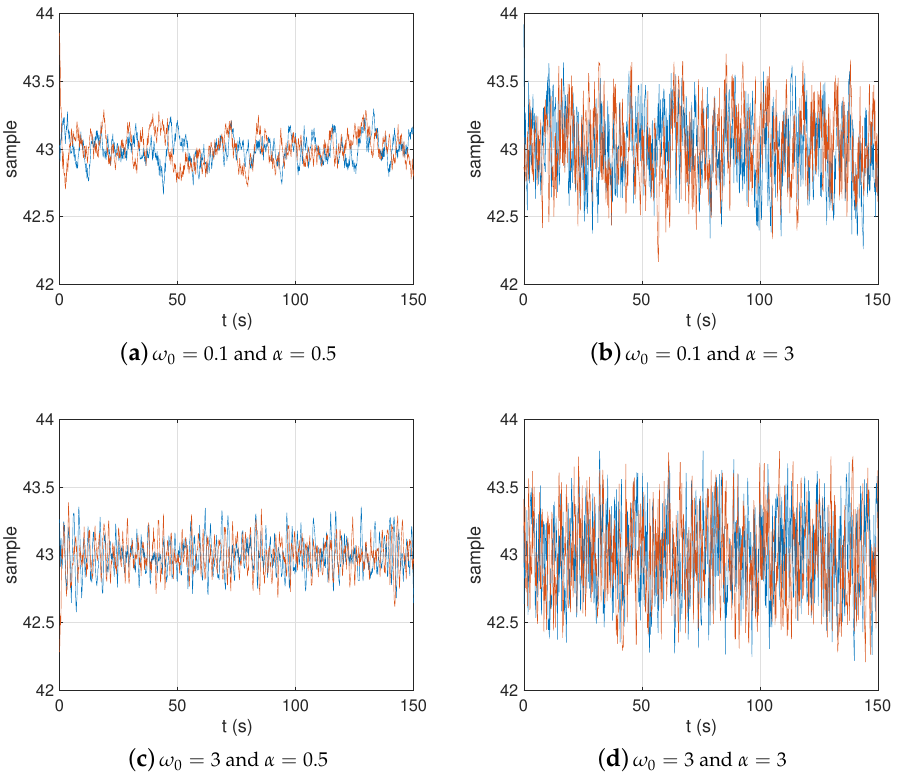
Figure 8. Samples with correlation function, r xx = Cos ( ω 0 t ) e − ατ , at different values of ω 0 and α